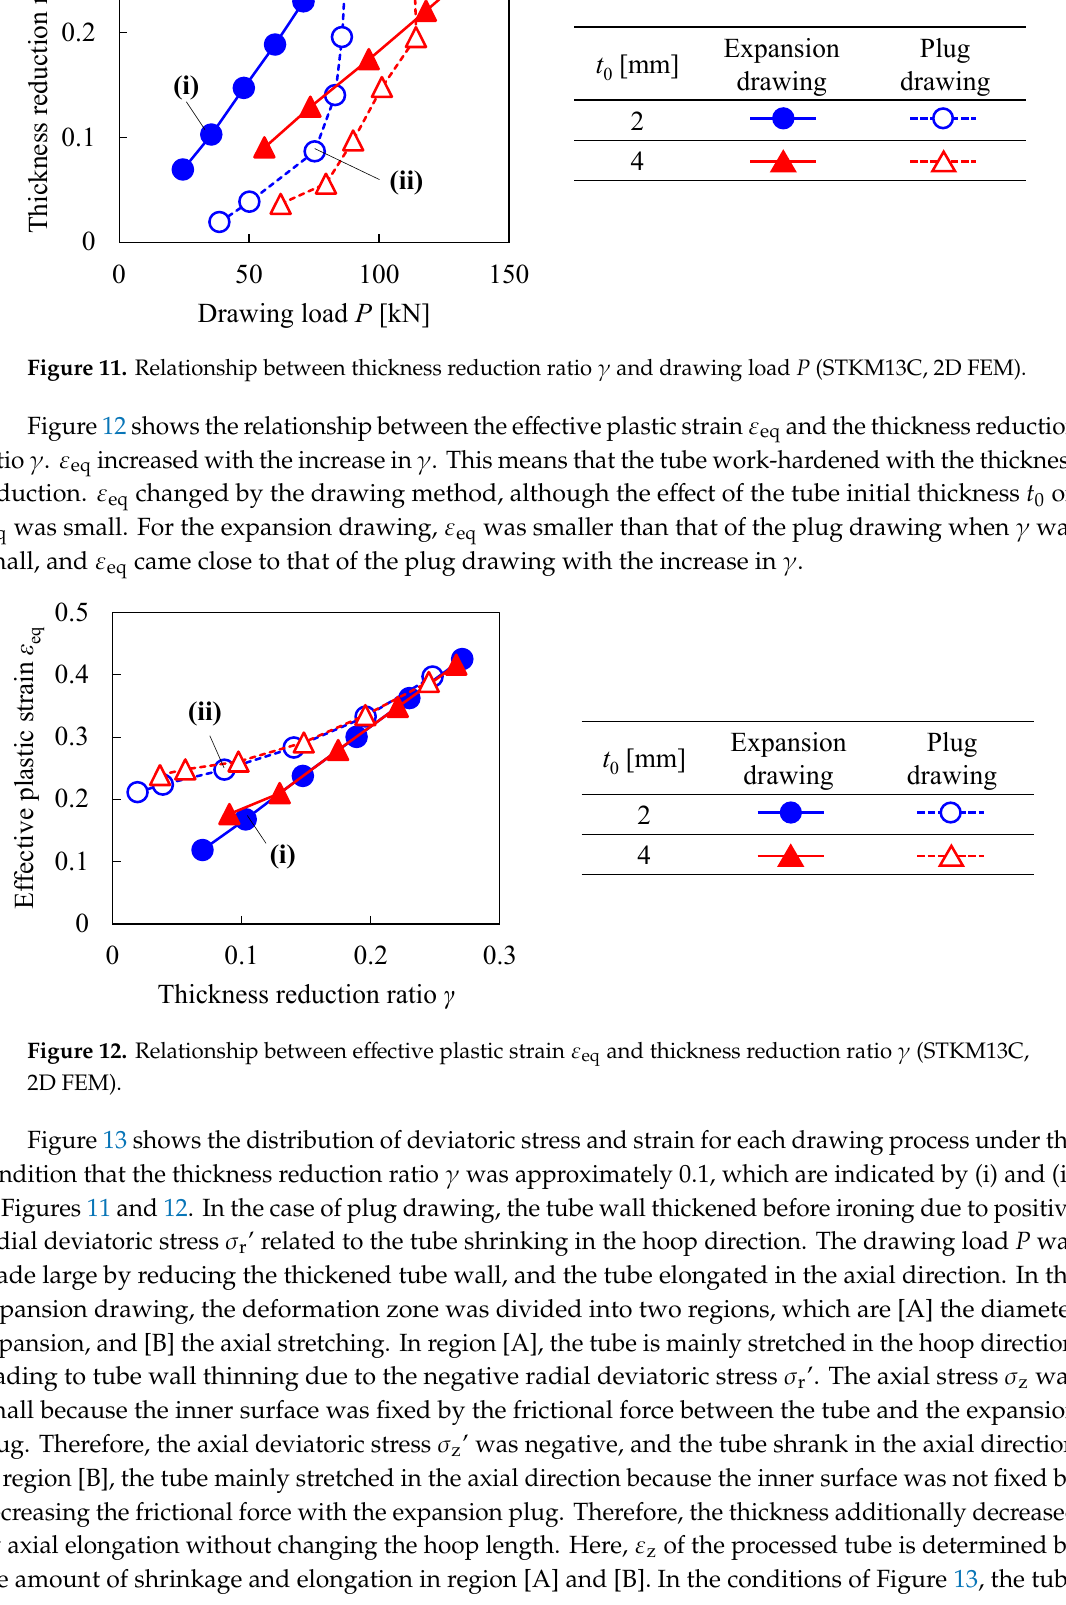
Figure 10. Effect of expansion ratio κ d on thickness reduction ratio γ (STKM13C, 2D FEM).